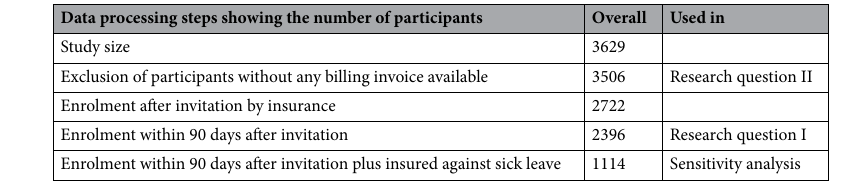
Table 1. Data preparation processes for selection of study population.